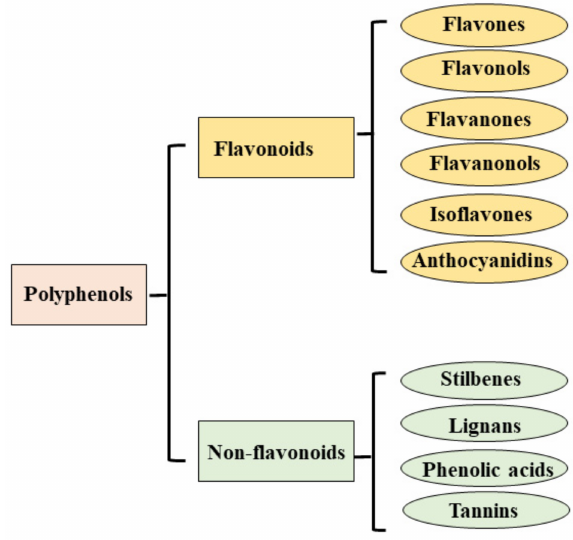
Figure 2. Classification of polyphenols.